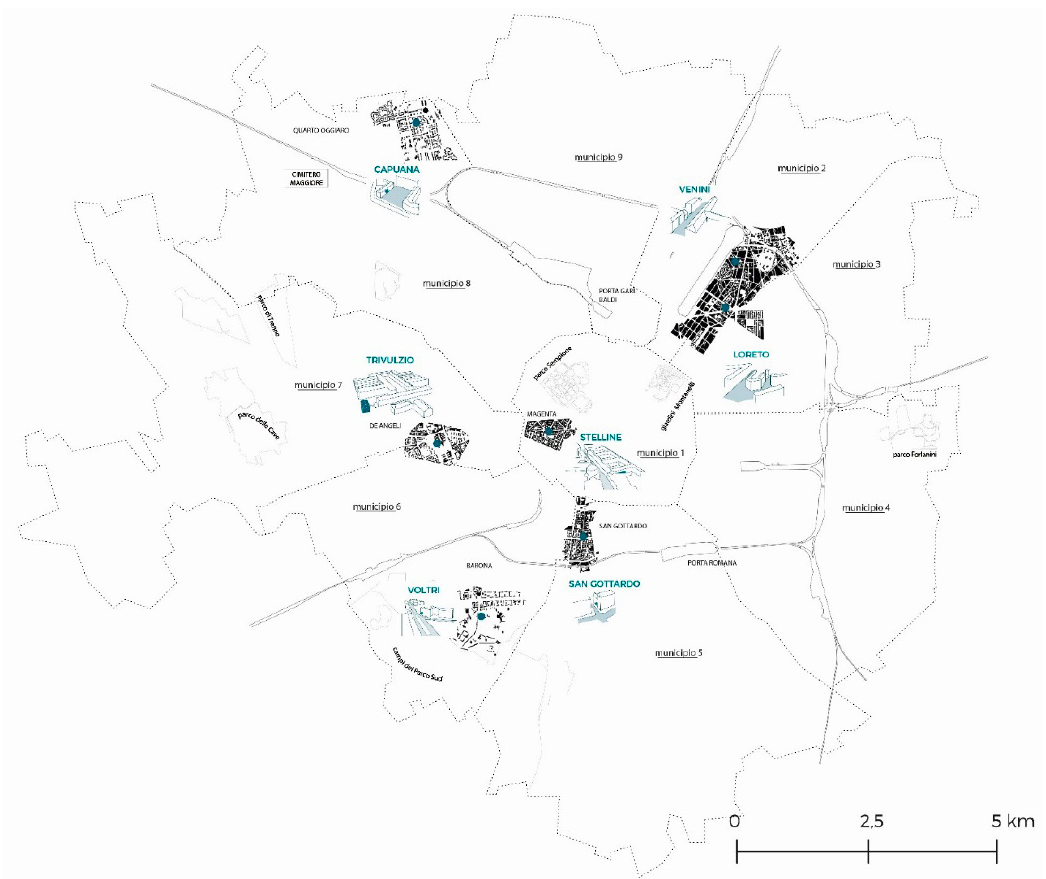
Figure 1. Localisation and morphological features of the WeMi spaces in the City of Milan,